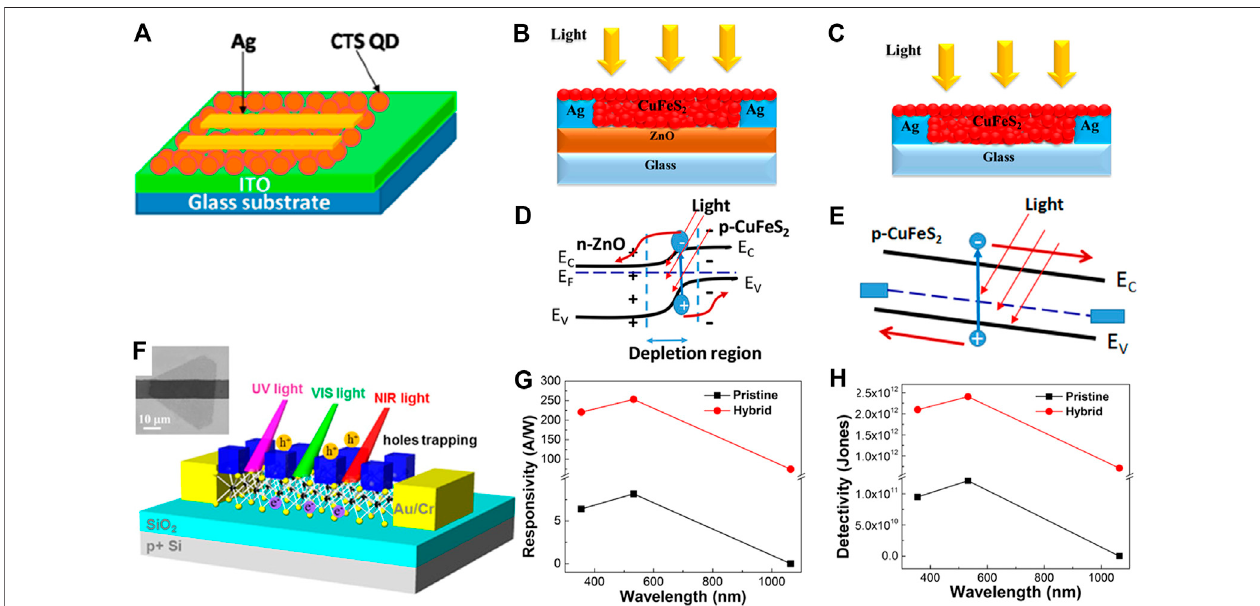
FIGURE6|(A) SchematicdiagramofthePDbasedonCu 2 SnS 3 QDs. Schematicillustration of (B) theCuFeS 2 QD/ZnOheterojunctionPDand (C) thesingle-layer CuFeS 2 QD PD. Schematic diagrams of energy band and charge transfer of (D) the heterojunction PD and (E) the single-layer PD. (F) Schematics of the hybrid FET. (G) Photoresponsivity and (H) speci fi c detectivity of the device as a function of wavelength. (A) Reprinted with permission from Inorg. Chem., 2017, 56, 2198 –